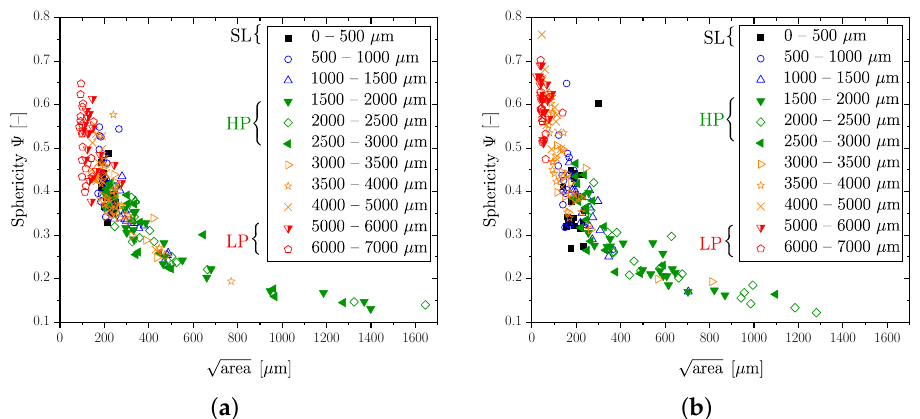
√ area perpendicular to the load direction of the investigated Figure 8. Sphericity over the projected positions evaluated by µ CT analysis. ( a ) CT results of thick-walled specimen Pos. A and C. ( b ) CT results of thick-walled specimen Pos.